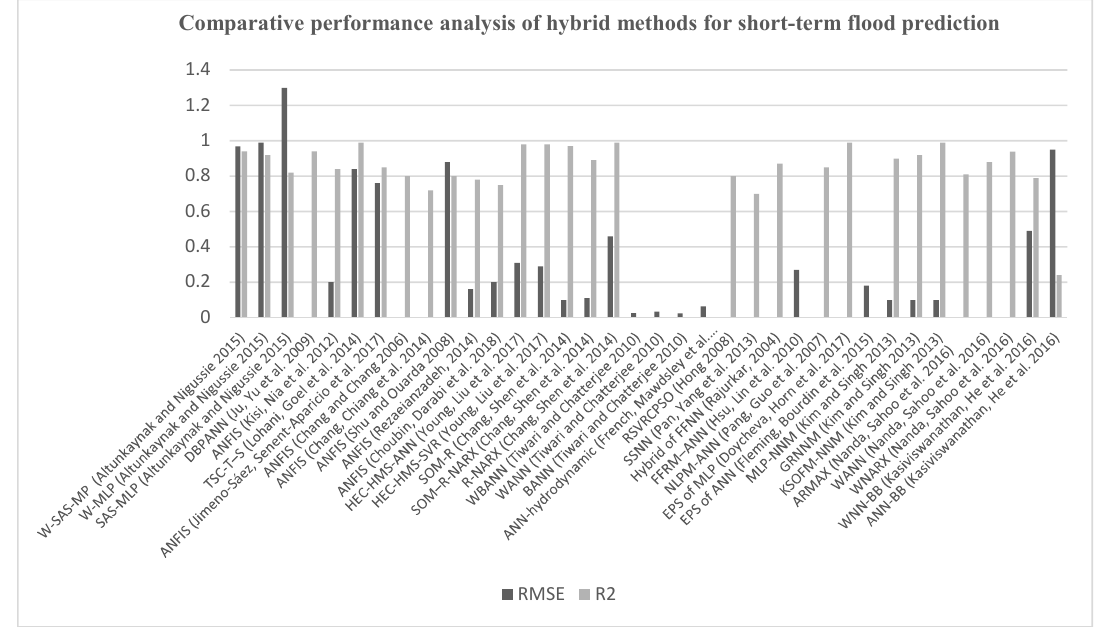
Figure 8. Comparative performance analysis of hybrid methods of ML for short‐term flood prediction, using R 2 and RMSE.